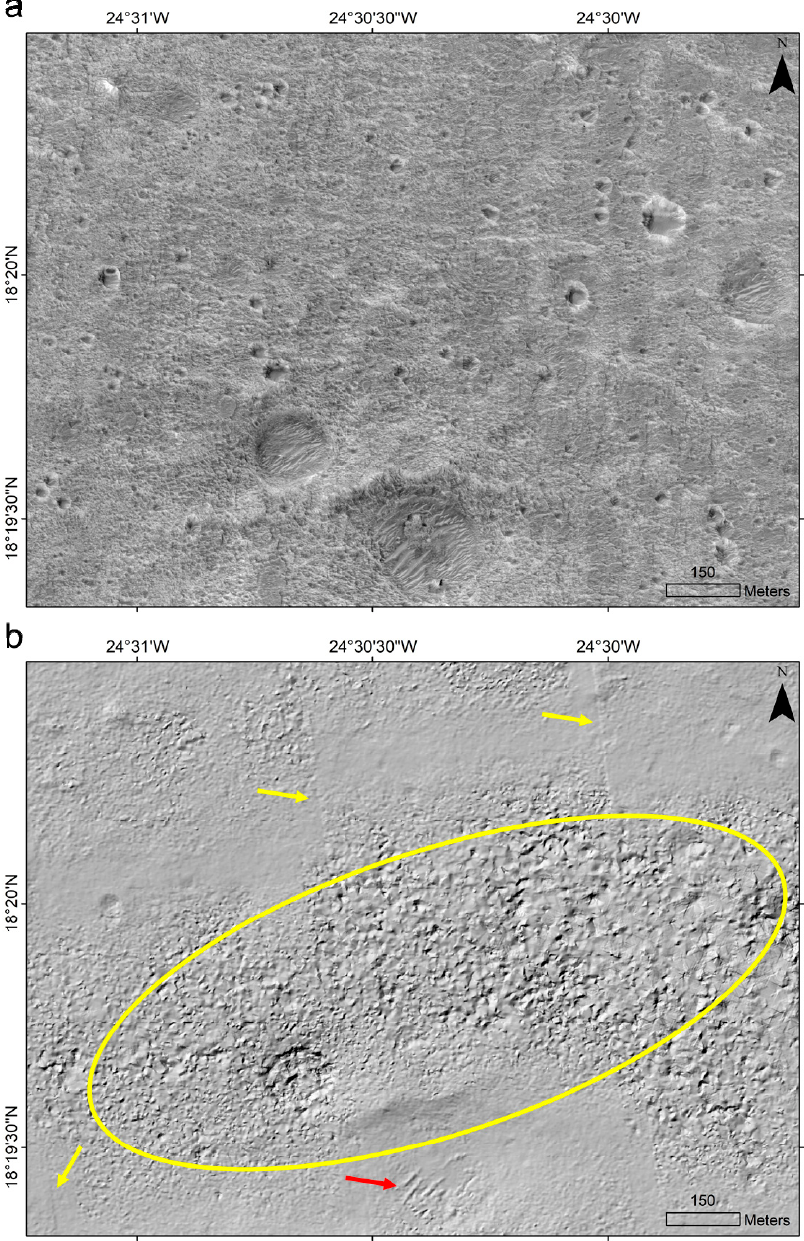
Figure 3. Common DTM artifacts. A region in Oxia Planum as seen in ( a ) HiRISE image PSP_009735_1985_RED and its corresponding ( b ) shaded relief derived from the DTM (DTEEC_009880_1985_009735_1985_L01; blue rectangle in Figure 2). The yellow ellipse highlights faceted areas and the yellow arrows highlight charged coupled device (CCD) seams. The red arrow shows clearly visible simple TARs. HiRISE image and DTM credit: NASA / JPL / University of